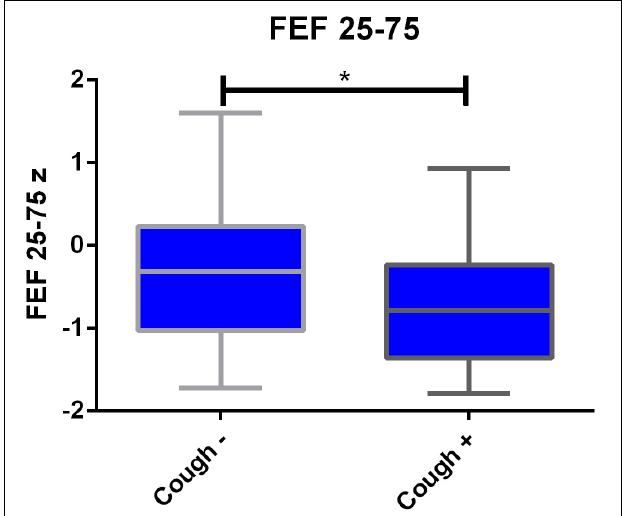
FIGURE 2 | Diminished FEF 25–75 z-score in all seropositive participants with cough during acute SARS-CoV-2 infection 12 months after the infection. Median, quartiles, minimum and maximum values in participants without ( n = 66) and with cough ( n = 42) during SARS-CoV-2 infection are visualized. * p < 0.05. FEF25–75z, normalized mean flow between 25% and 75% of the forced vital capacity.